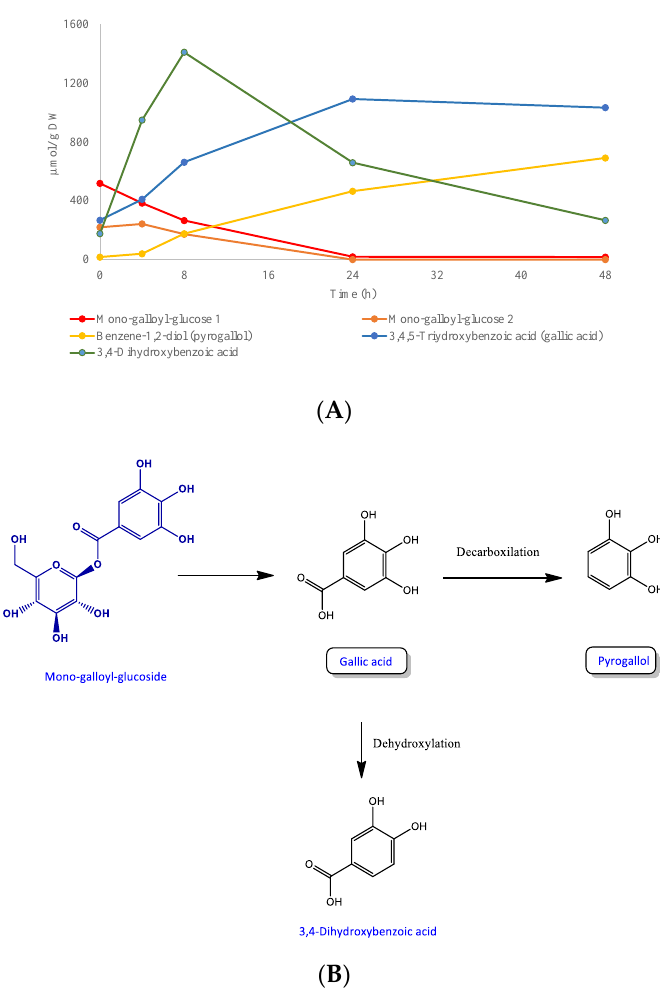
Figure 1. ( A ) Monogalloyl hexoside degradation profiles over 48 h of incubation with human faeces. Data expressed as µ mol ± SD ( n = 3). ( B ) Proposed catabolic pathway for the colonic transformation of mono-galloyl-hexoside in humans. Framed names indicated major catabolites.